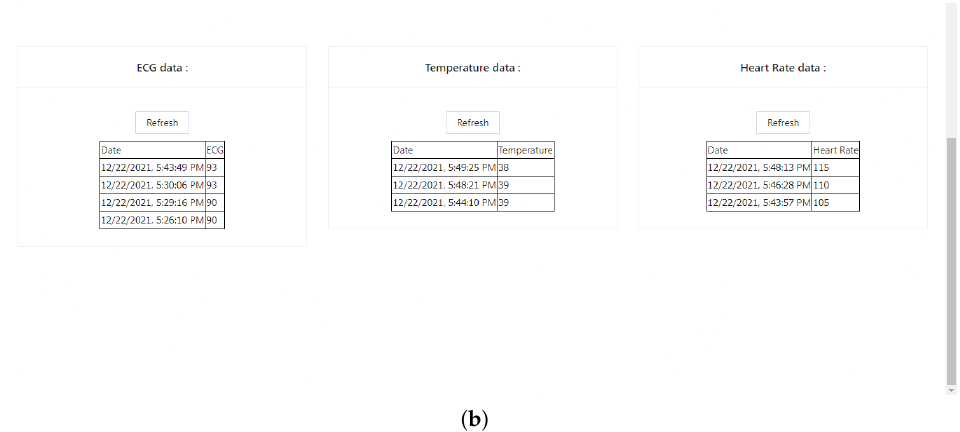
Figure 5. Web-based patient interface of the HCS Blockchain implementation. ( a ) Patient information and functionalities; ( b ) Patient monitored health care